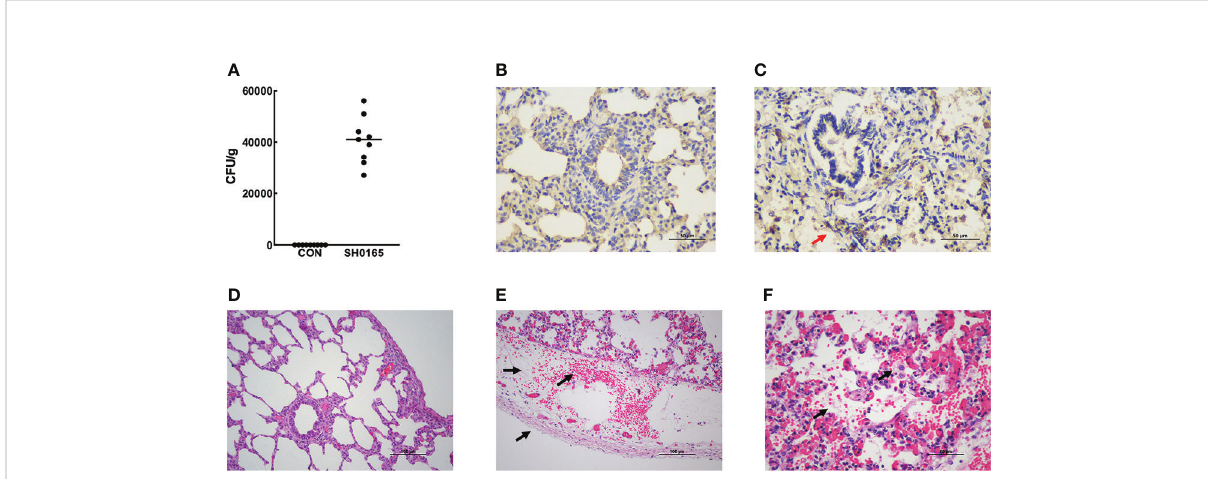
FIGURE 1 Establishment of G parasuis infection model and Examination of pathological changes in lung induced by G parasuis high-virulence strain SH0165. (A) Colony counts of G parasuis in lung tissue. (B, C) Immunohistochemistry to detect G parasuis in lung tissue. (B) Control group. (C) SH0165 infection group. The accumulation of bacteria was indicated by red arrows. After infection with SH0165 at 24h post-infection, lung tissues were collected for H&E staining. Piglets were injected with PBS as a control. Compared with the control group (D) , various pathological changes were observed in the section of the G parasuis infection group: (E) bleeding, pleural thickening, lymphatic dilatation (black arrows), (F) fi brinous exudation in the alveolar space, macrophage in fi ltration which were indicated by black arrows. Scale bar: 50 m m (B, C, F) and 100 m m (D, E) .